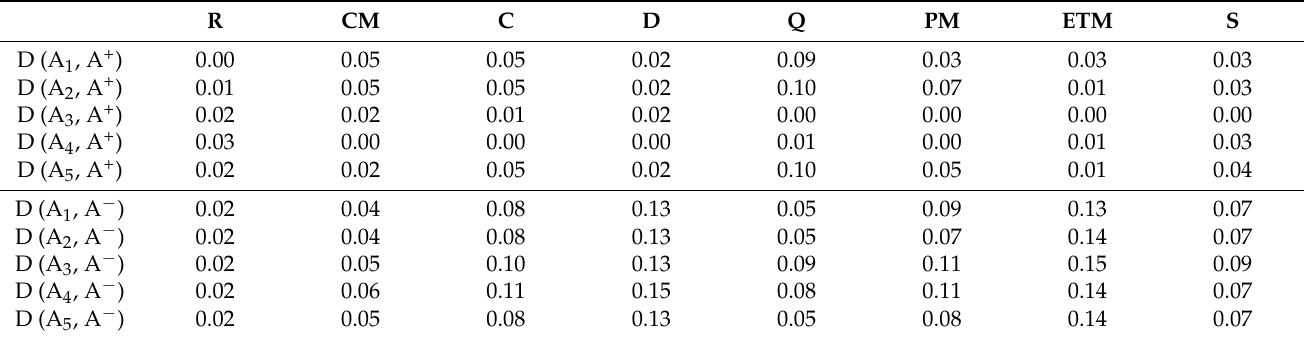
Table 9. Distance from A + and A − based on the rating of each